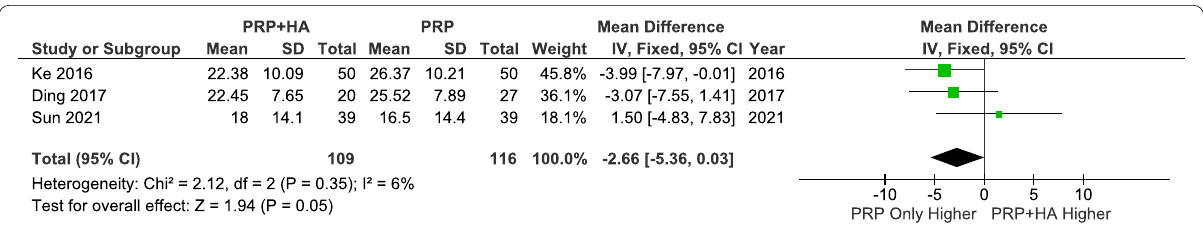
Fig. 12 Showing the Forest plot comparing the WOMAC function scores between PRP